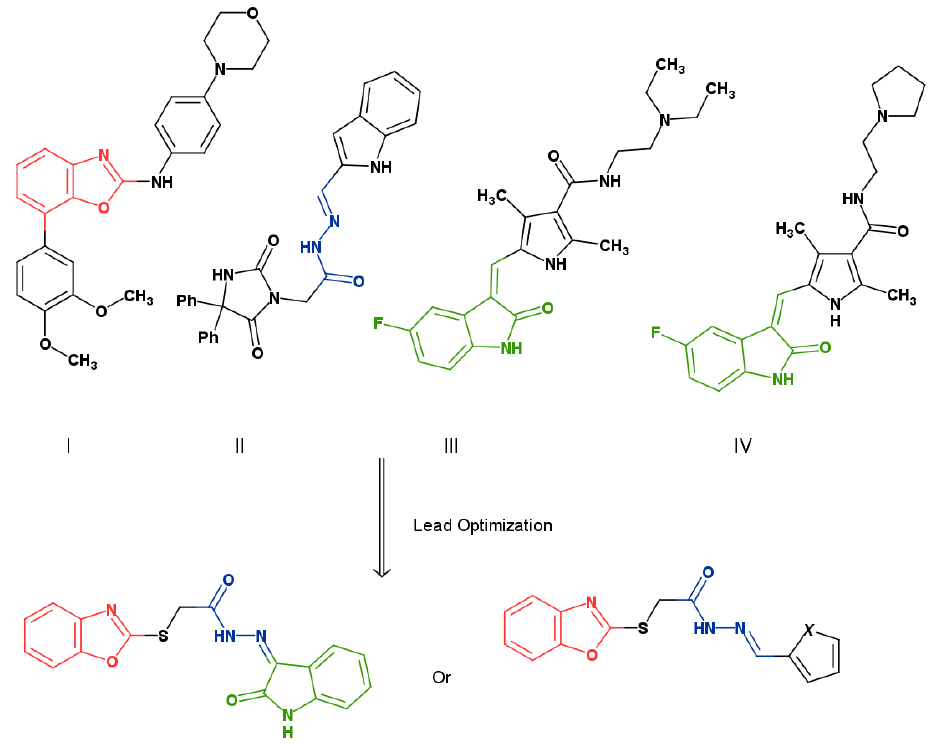
Figure 1. The reported and proposed benzoxazole, hydrazone, and isatin conjugates with anticancer activity.